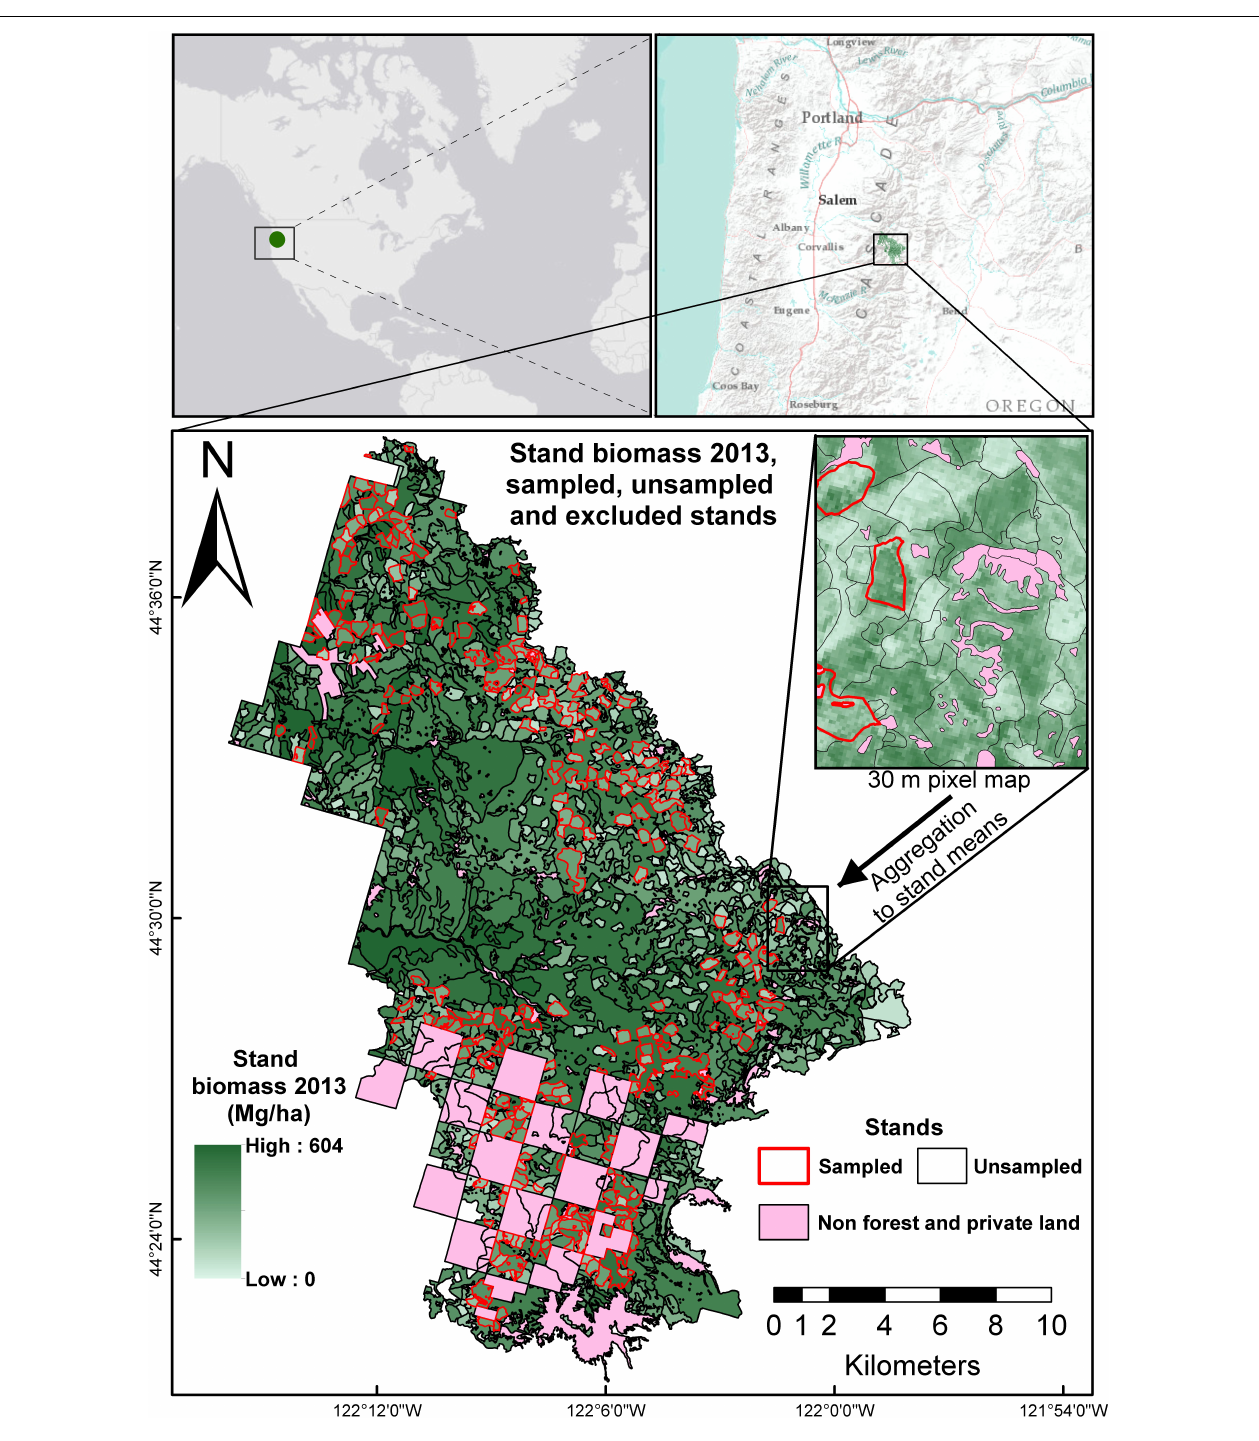
FIGURE 1 | Location of the study area. In pink are stands excluded from the analysis because they were not covered by the remote sensing inventory from 2013. Stands in green color with red outline are sampled stands; and green stands with black outline are unsampled stands.